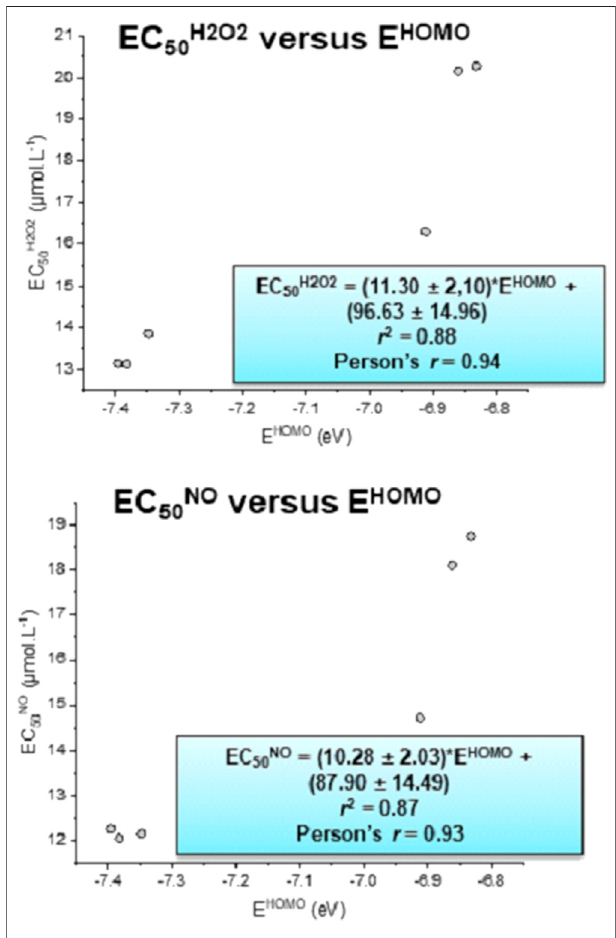
FIGURE 3 | HOMO energy (E HOMO ) correlated with EC 50NO and EC 50H2O2